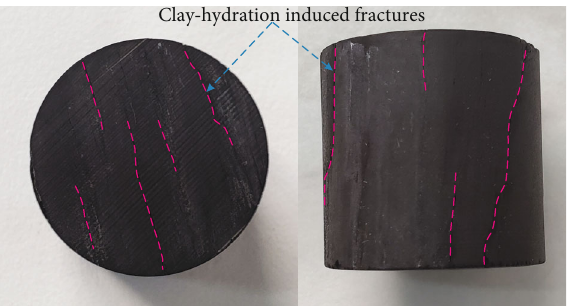
Figure 9: Clay hydration-induced fractures of the deep shale during imbibition.